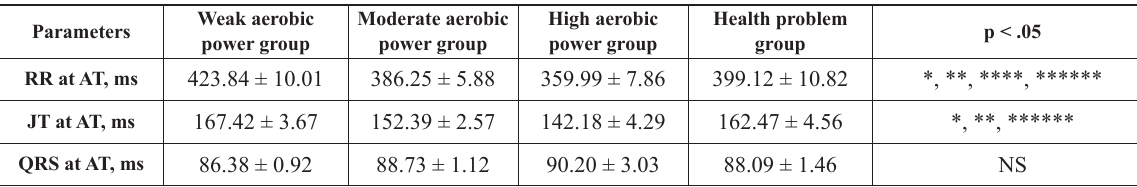
Table 2. ECG durational parameters at the anaerobic threshold during bicycle ergometry